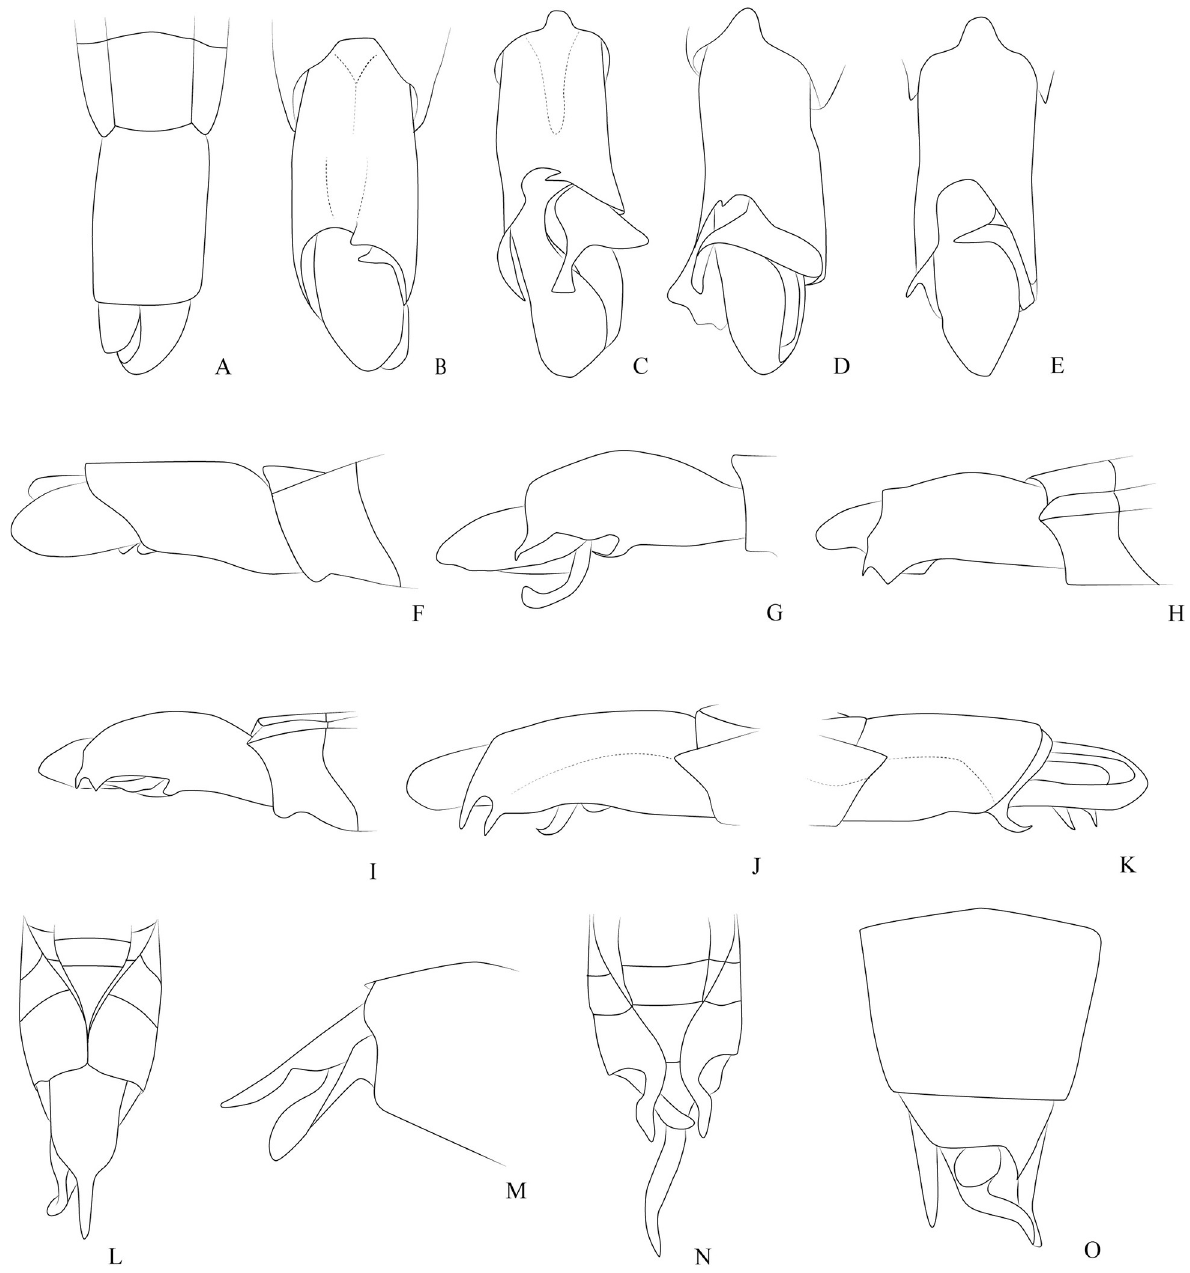
Fig 25. P . bilobulatus (B, G, O); P . manzoneae (A, C, H, M, Q); P . shuar (D, I); P . spiculus (E, J, K, N); P . tridentatus (F, L, P). (A) Male, terminalia, dorsal view; (B-F) Male, terminalia, ventral view; (G-L) Male, terminaria, lateral view; (M, N) Female, terminalia, dorsal view; (O, P) Female, terminalia, ventral view; (Q) Female, terminalia, lateral